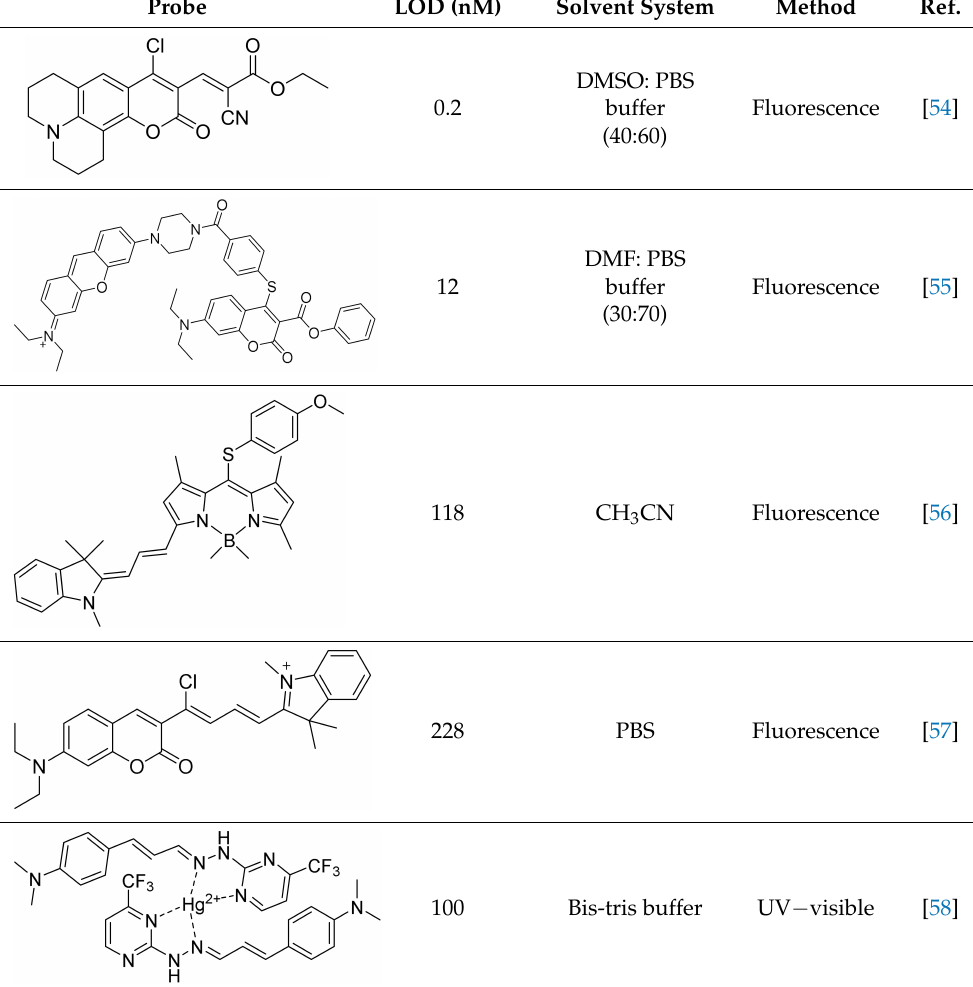
Fluorescence spectroscopy